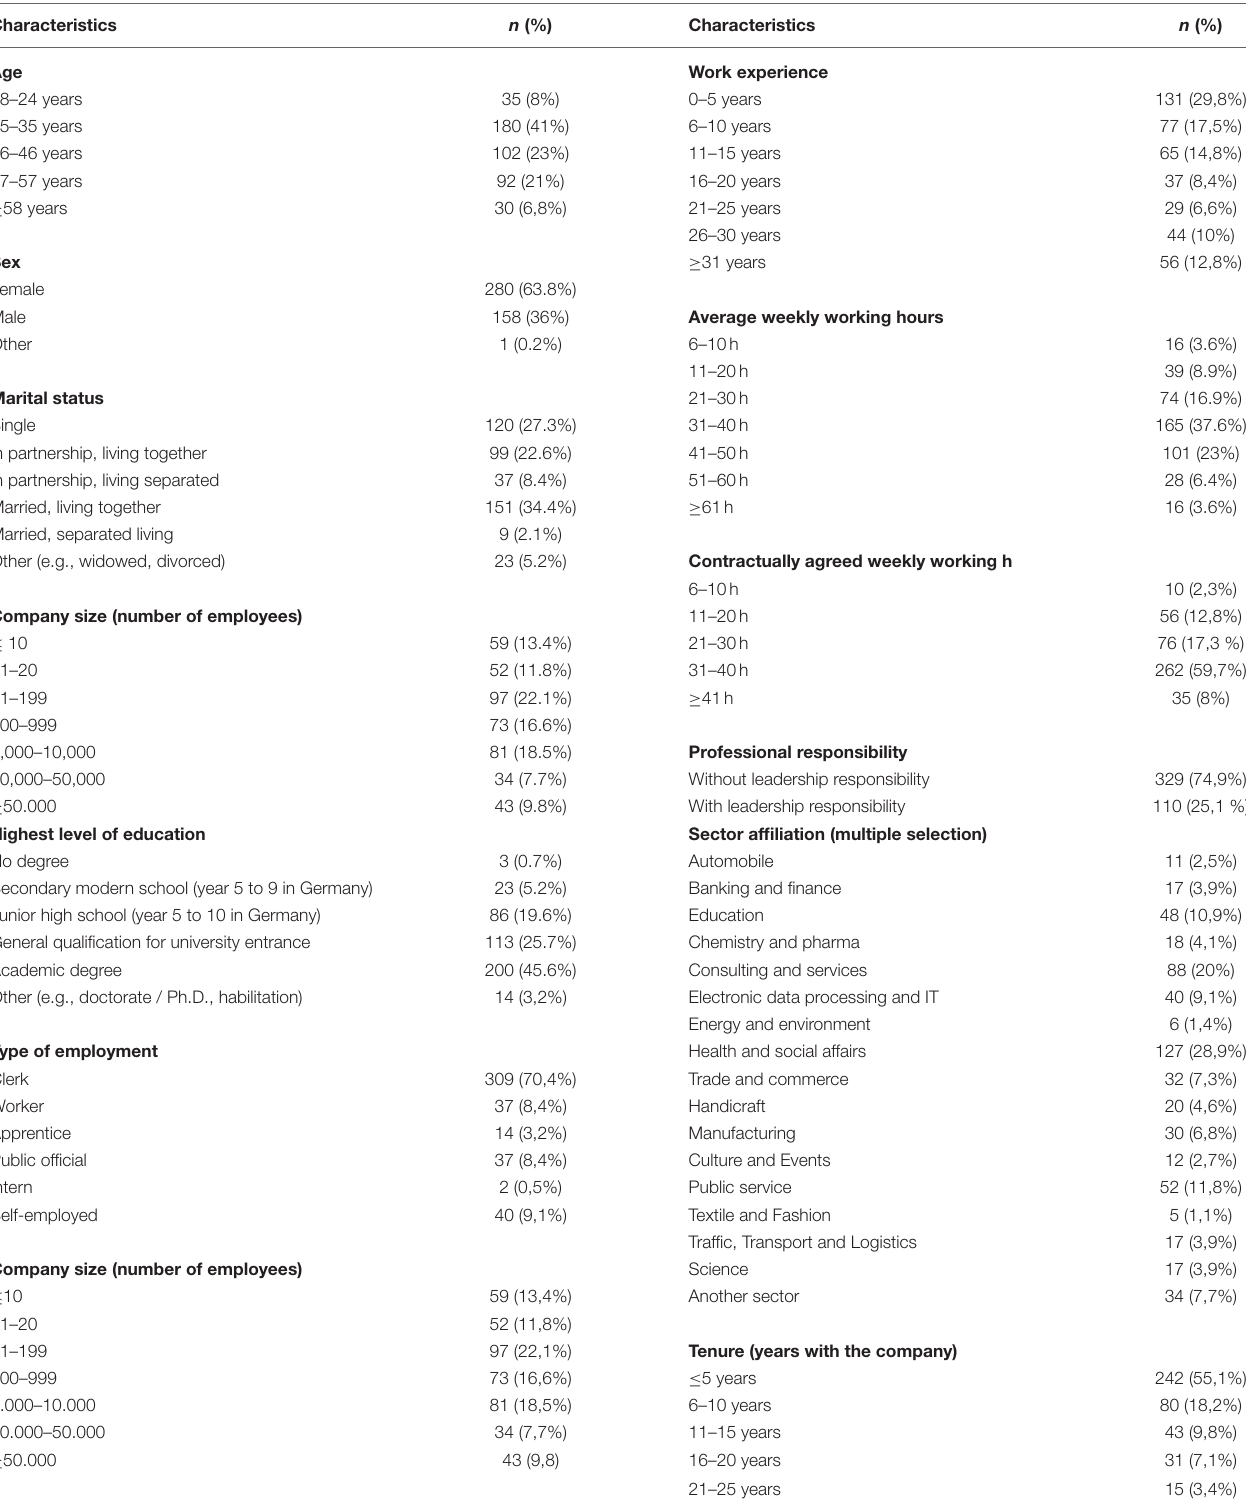
TABLE 1 | Baseline characteristics of the study population ( n = 439).